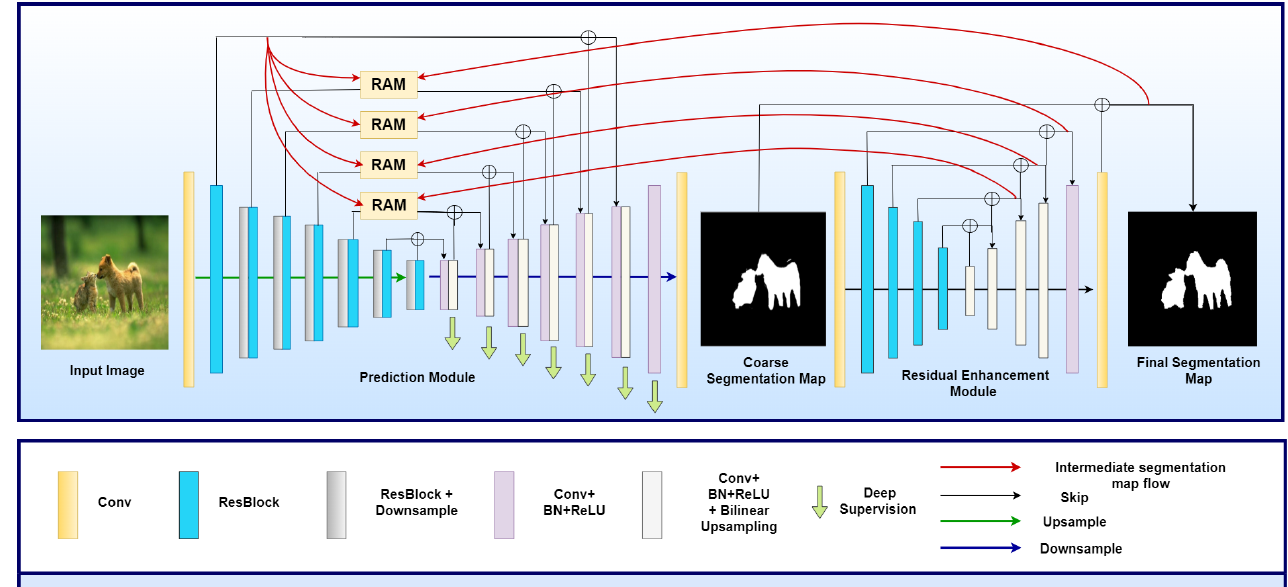
Figure 1. Overall framework for the proposed Revise-Net model consisting of two cascaded encoder–decoder modules. The first module is a U-Net-like architecture with residual blocks in the encoding and decoding layers. The second module is the REM to fine-tune the output predicted map. Finally, the RAM modules are cascaded between the two networks for revising the final saliency